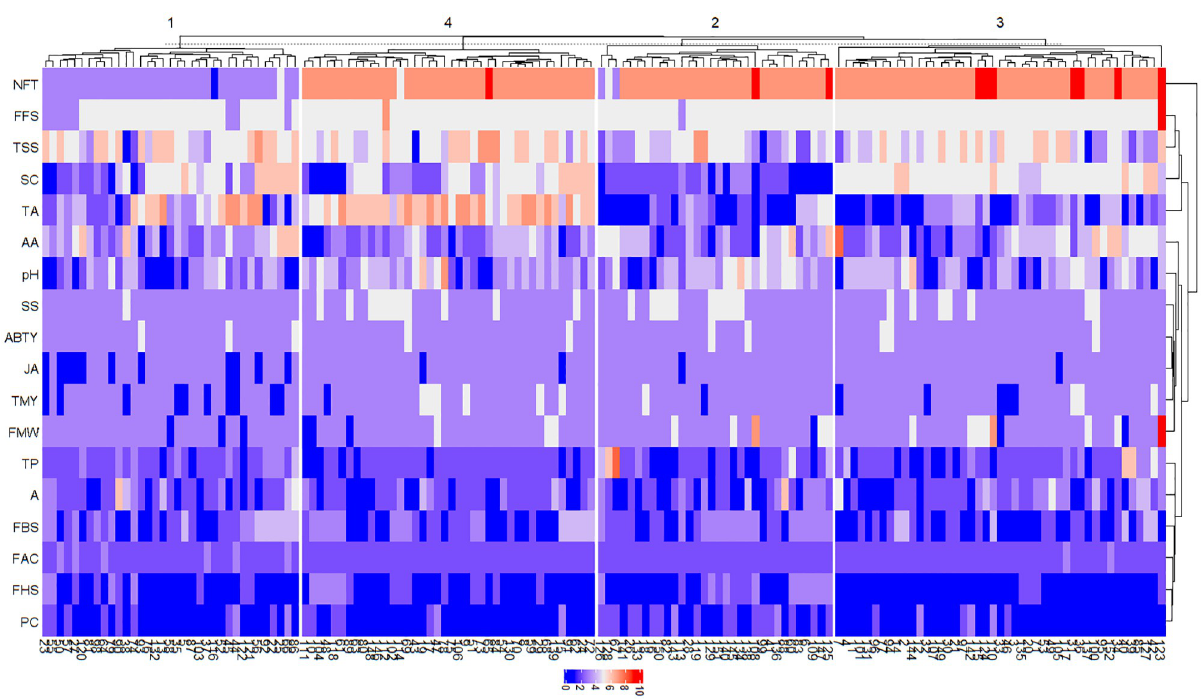
Fig 8. Metabolic and morphological traits heatmap of the 152 pomegranate genotypes based on Euclidean distances.